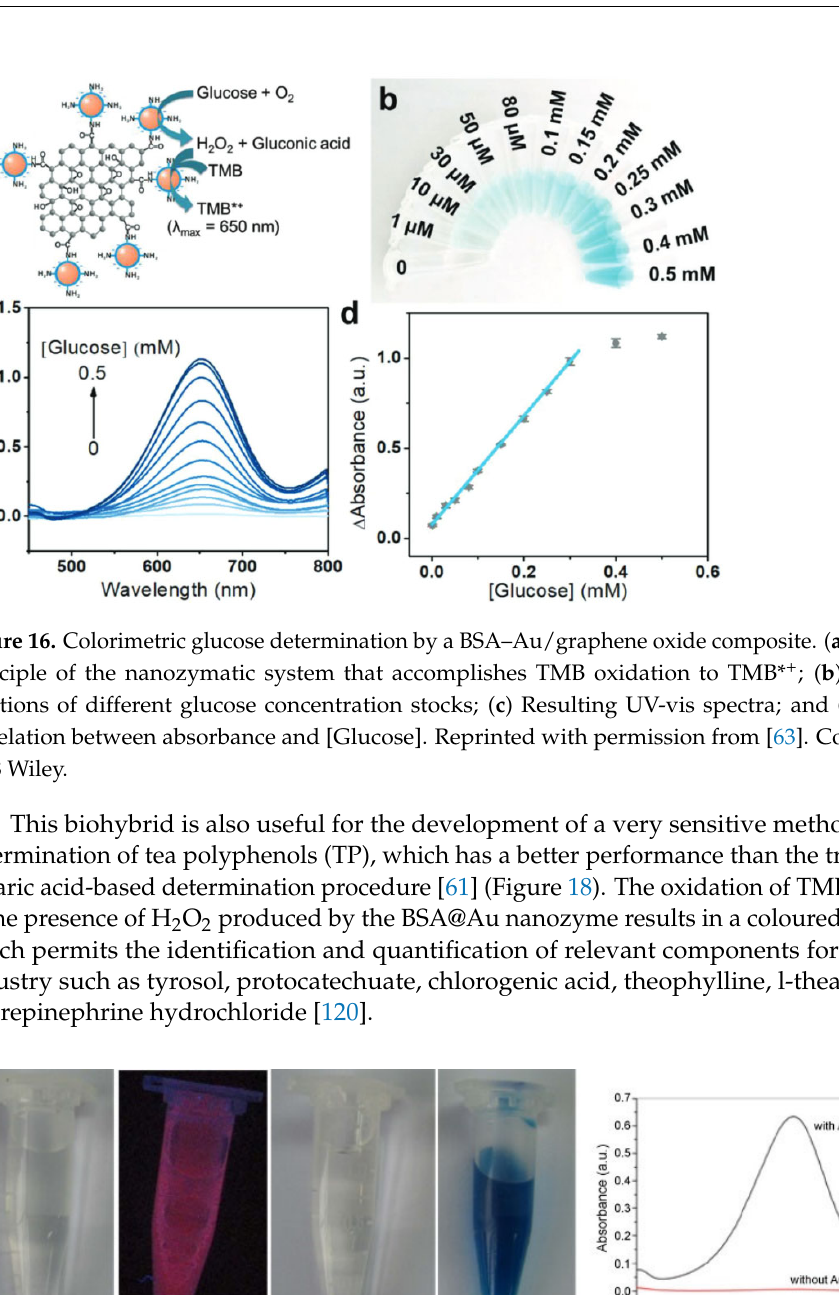
Figure 17. Colorimetric response of BSA–Au clusters under UV radiation and in the presence of H 2 O 2 . UV–vis spectra of a TMB and H 2 O 2 solution in the presence and in the absence of the BSA– Au nanozyme. Reprinted with permission from [62]. Copyright © 2011 Elsevier.